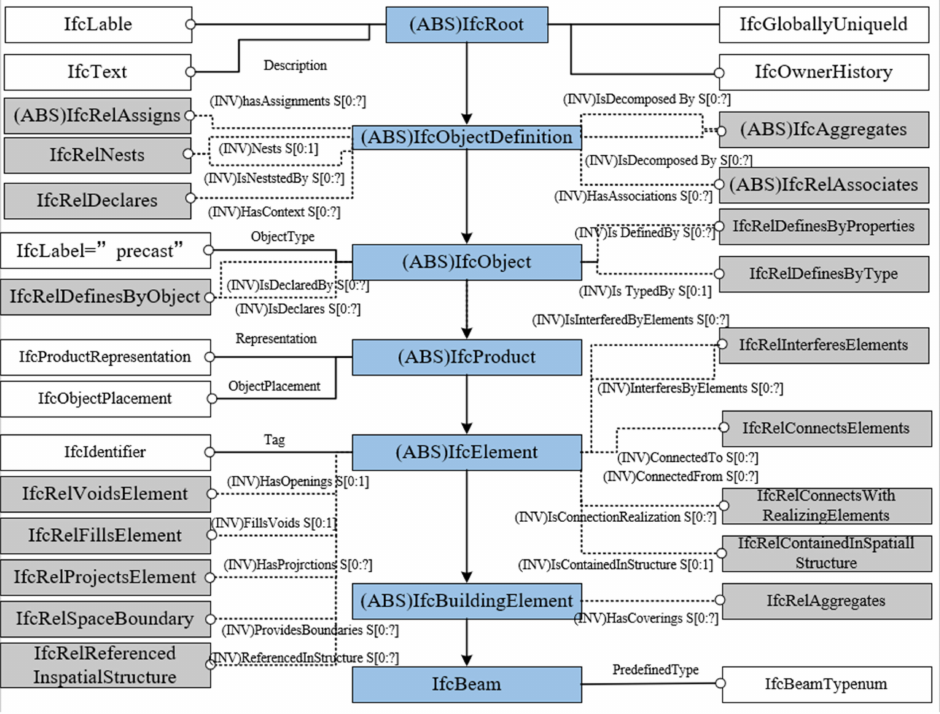
Figure 3. Definition of the IFC Architecture of a